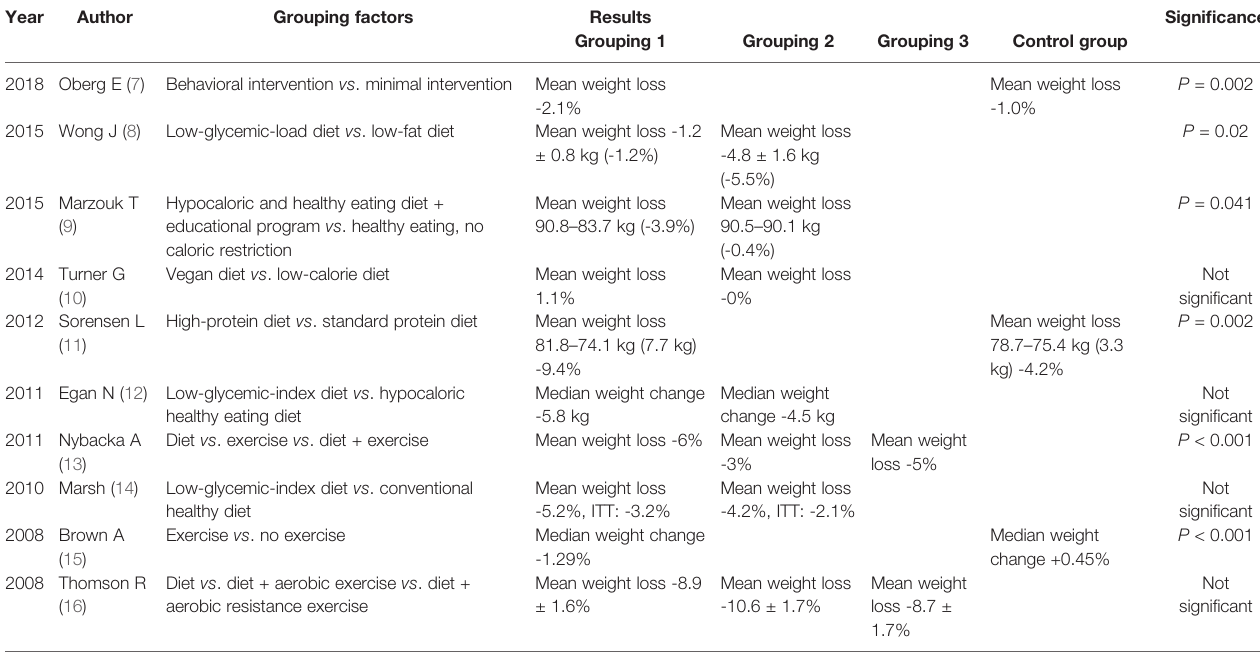
TABLE 1 | Results of the 10 enrolled randomized controlled trial